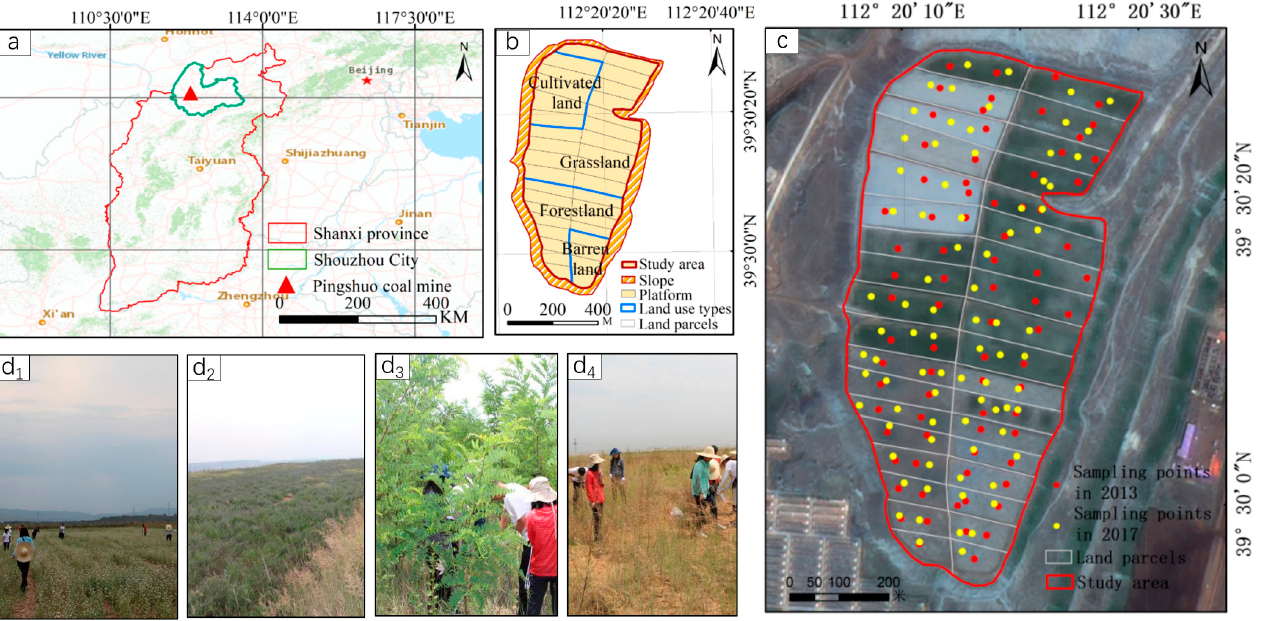
Figure 1. Geographical location and distribution of quadrats in the study region (( a ) Pingshuo coal mine in Shouzhou city in Shanxi Province; ( b ) the land reclamation design diagram of the inner dump; ( c ) the distribution map of soil sampling sites; ( d 1 ) field pictures in the cultivated land; ( d 2 ) field pictures in the grassland; ( d 3 ) field pictures in the forestland; and ( d 4 ) field pictures in the barren land).